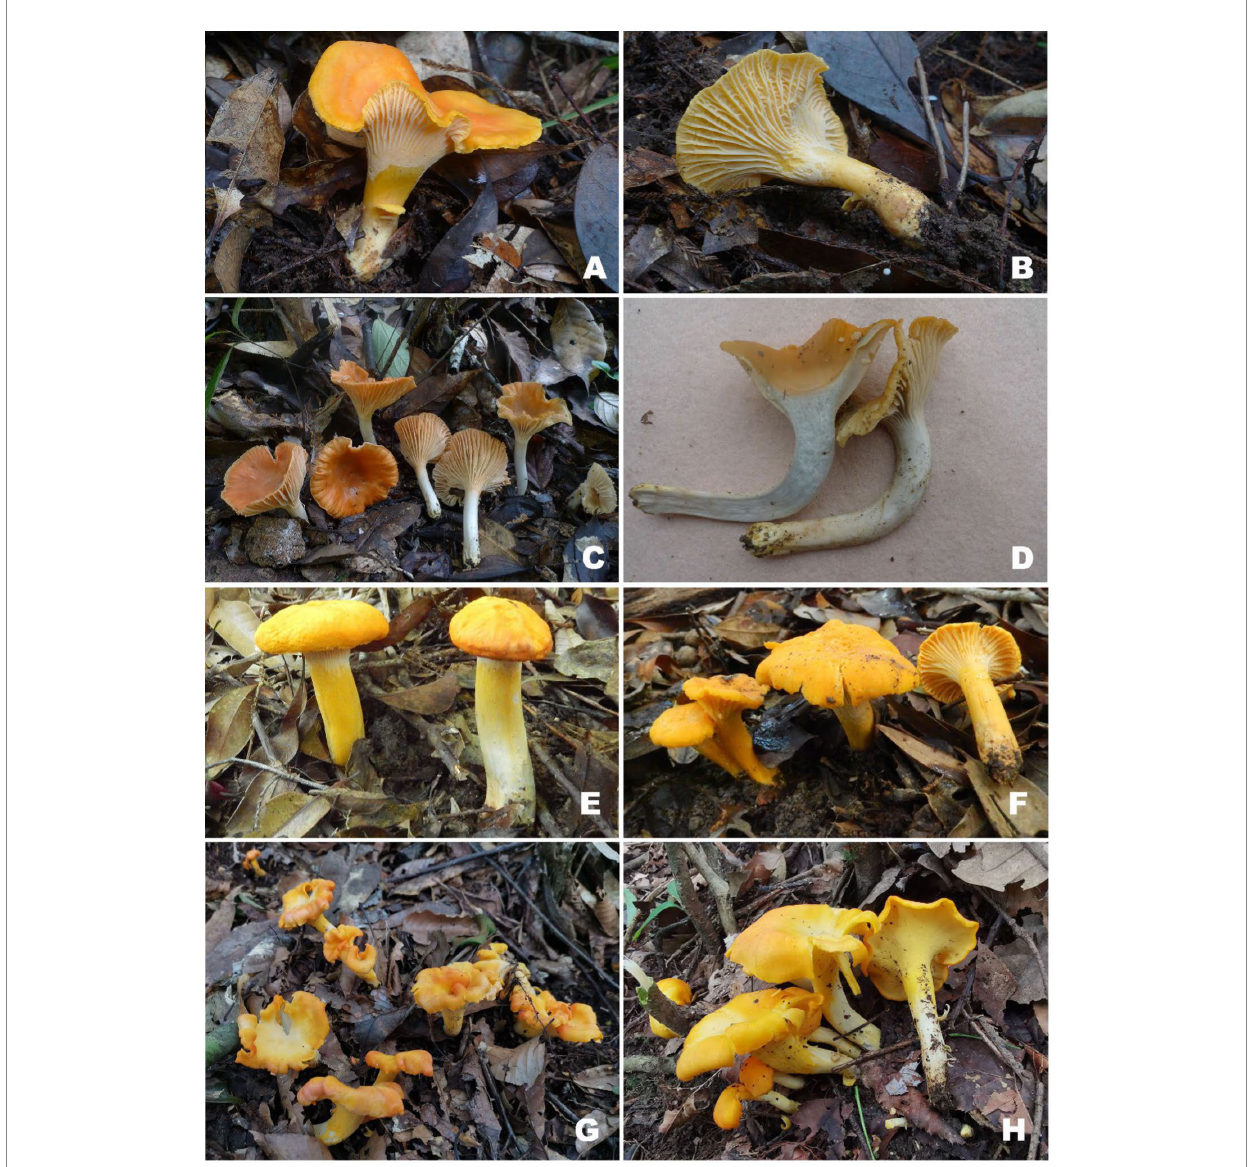
FIGURE 2 Basidiomata of Cantharellus subg. Afrocantharellus species. (A,B) Cantharellus bellus (FHMU2422, holotype); (C,D) Cantharellus cineraceus (C) FHMU968, holotype; (D) FHMU966; (E,F) Cantharellus hygrophoroides (E) FHMU2421; (F) FHMU1635; (G,H) Cantharellus laevigatus (G) FHMU6955, holotype; (H) FHMU6952; Photographs: (A–F) N. K. Zeng; (G,H) Z. H.